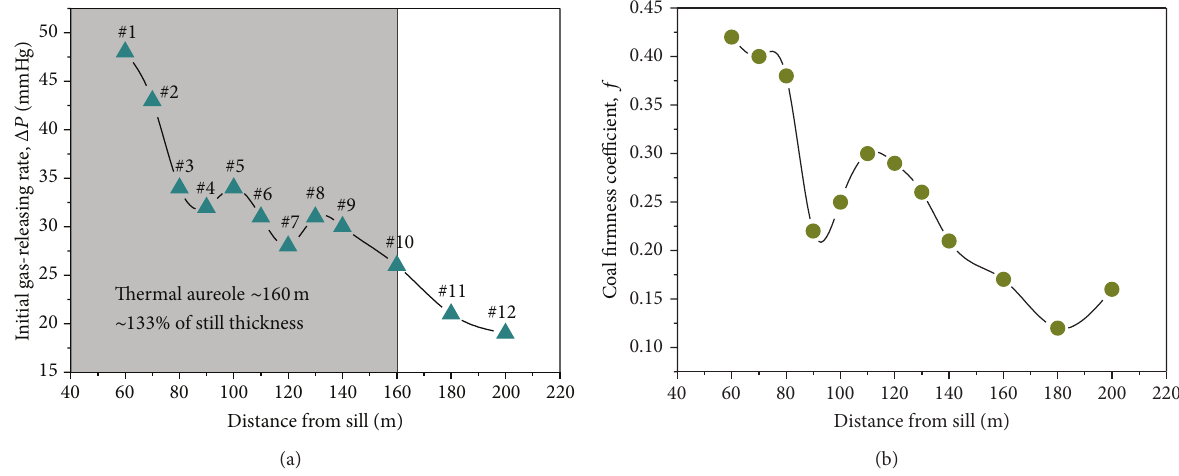
Figure 11: Relation between methane initial gas-releasing rate Δ𝑃 (a), coal firmness coefficient 𝑓 (b), and distance from sill.